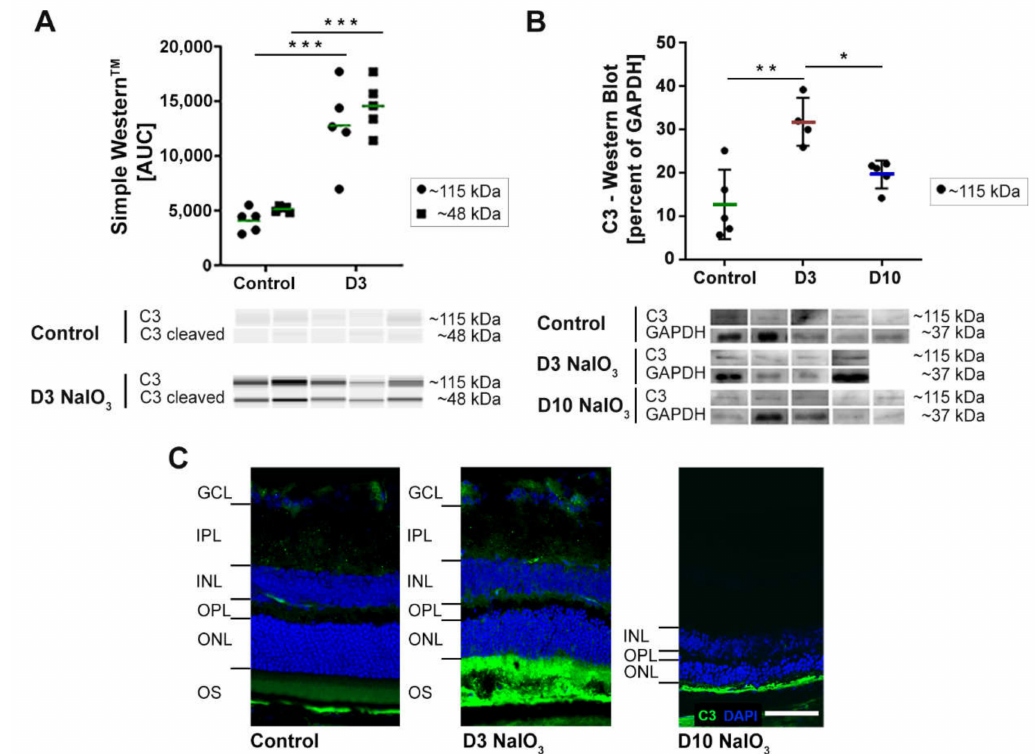
Figure 3. The C3 protein signals in murine neurosensory retina were increased after the NaIO 3 treatment. ( A ) The protein levels of the complement component C3 were significantly increased at day 3 after the NaIO 3 treatment in all the samples compared to the untreated control using Simple Western TM technology. Full blots are shown in Supplementary Figure S3A. ( B ) The Western blot signals of C3 in the retinal protein extracts of NaIO 3 -treated mice under waning conditions were increased three days after treatment. The C3 protein levels were comparable to the untreated controls at day 10. GAPDH was used as a housekeeping protein. The intensity of the C3 signal in 3A and 3B was measured using ImageJ software. * 0.01 < p < 0.05, ** 0.001 < p < 0.01 and *** 0.0001 < p < 0.001 (one-way ANOVA, Tukey’s multiple comparisons test). The full blots are shown in Supplementary Figure S3B. ( C ) The immunohistochemical stainings of C3 and DAPI three days and ten days after the NaIO 3 treatment showed C3 accumulation in the POS at day 3, whereas the signal decreased after ten days. At this point in time, the ONL and PS thickness were reduced (see, also, Figure 1). Scale bar: 50 µ